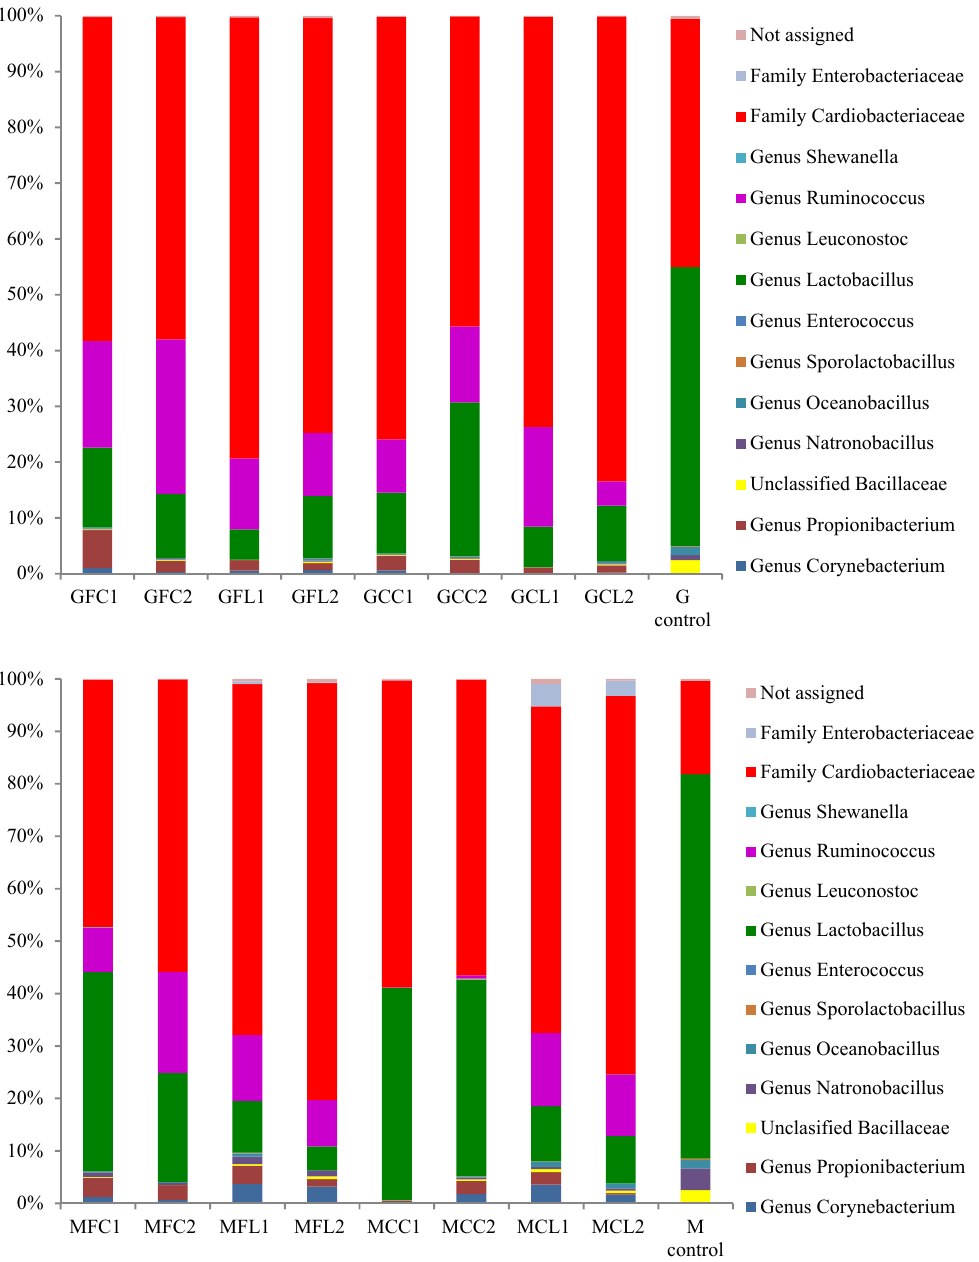
Figure 3. The relative abundance (%) of the bacterial genera or family obtained by the pyrosequencing analysis at the post-fermentation stage. The results of the G and M controls correspond to a blend of both duplicates. See Table 5 for the meanings of the samples abbreviations.